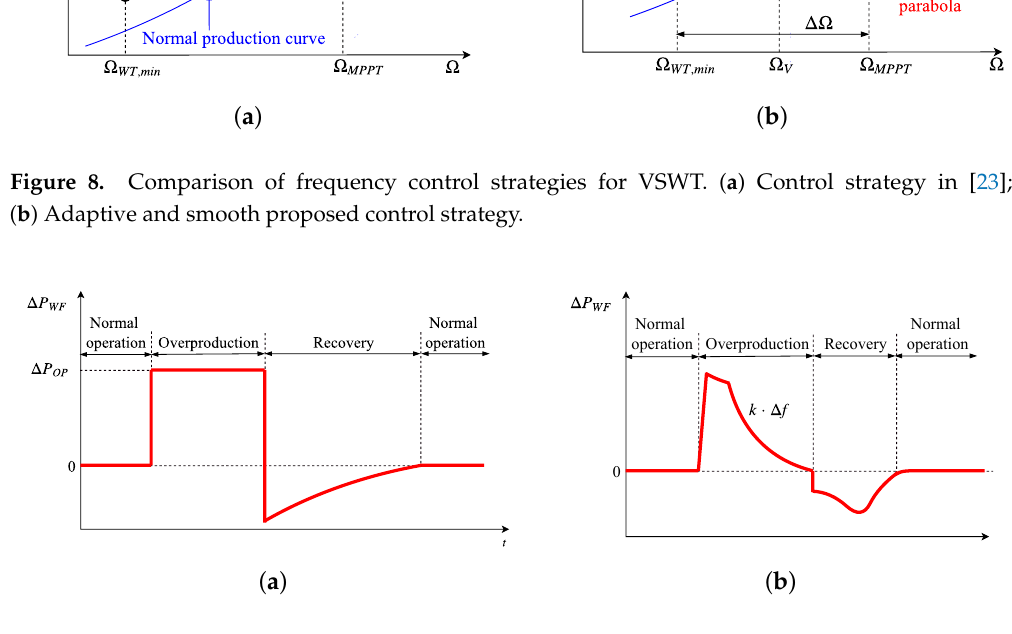
Figure 7. Different proposals for recovery operation mode